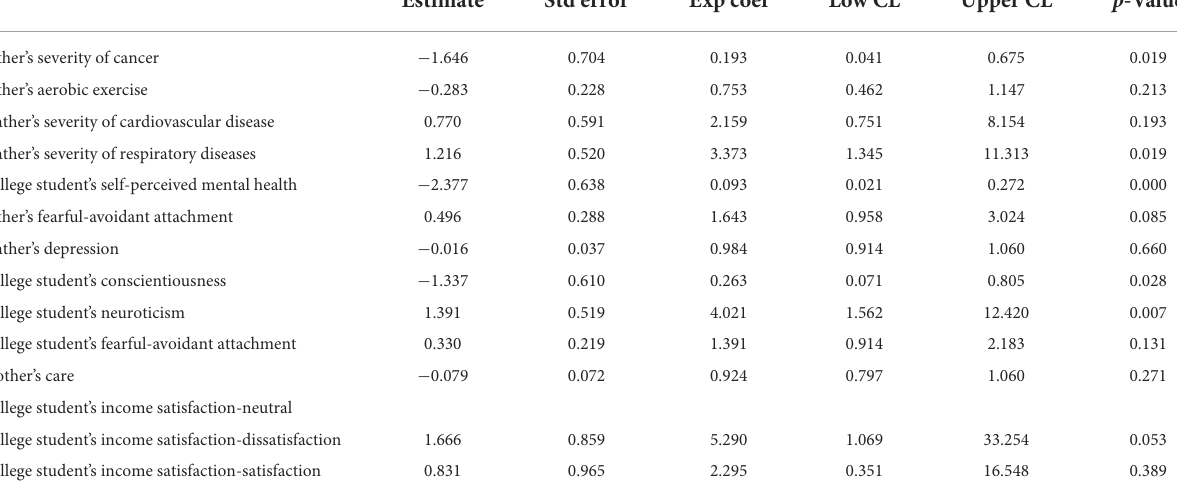
TABLE 4 Logistic regression analysis